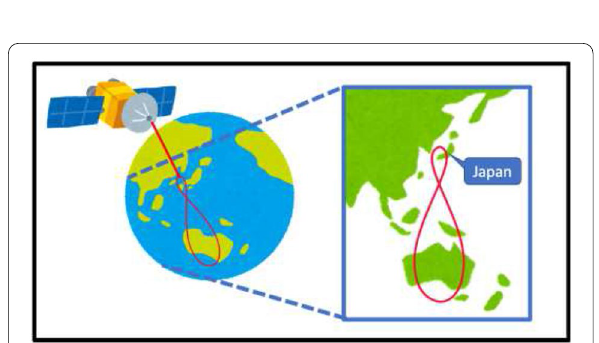
Fig. 4 Quasi-zenith orbit. The red-colored trajectory is the quasi-zenith orbit [17]. The trajectory covers Japan and